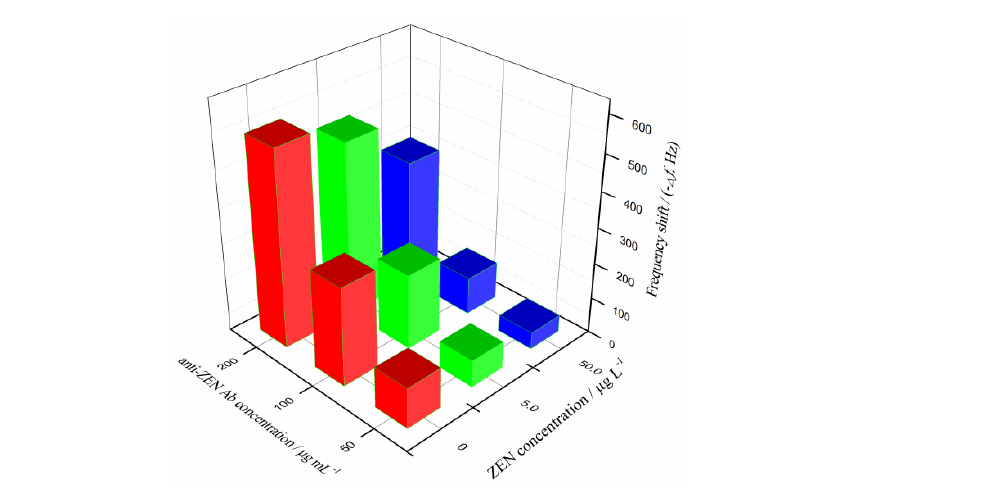
Figure 3. Comparison of frequency shift at the tested ZEN concentrations, using different concentra- tions of anti-ZEN Ab.